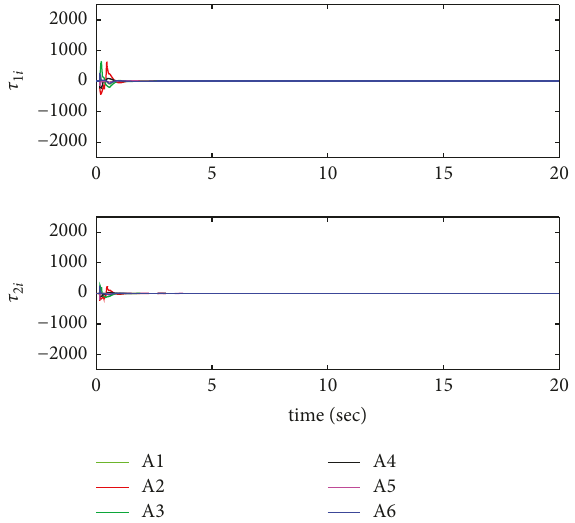
and τ and the fault-free case (AFSFC). 1 i 2 i